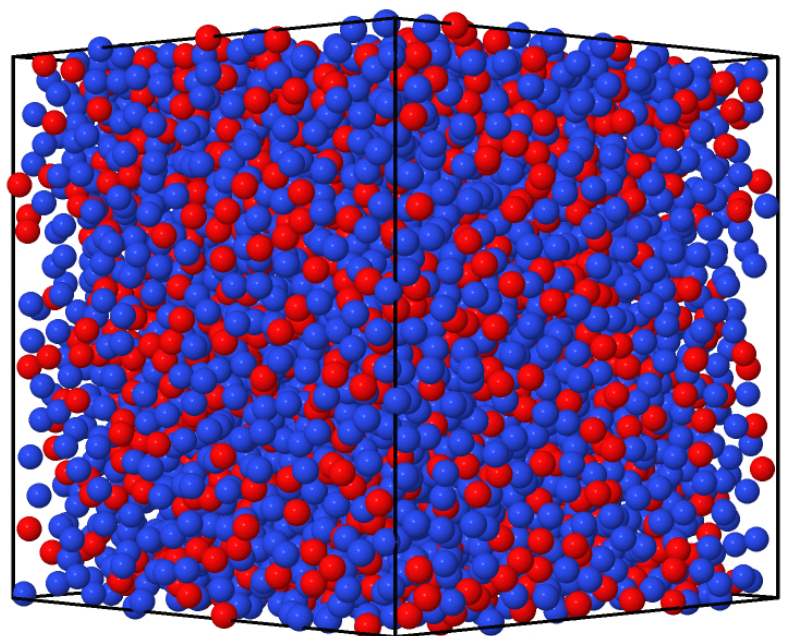
Figure 9. Snapshot of the NiY 2 binary LJ system at ( ρ , T ) = ( 1.3,1.0 ) , the reference state point for the isomorph studied. The A particles representing the Yttrium atoms are blue and the B particles representing the Nickel atoms are red. We see that the system is